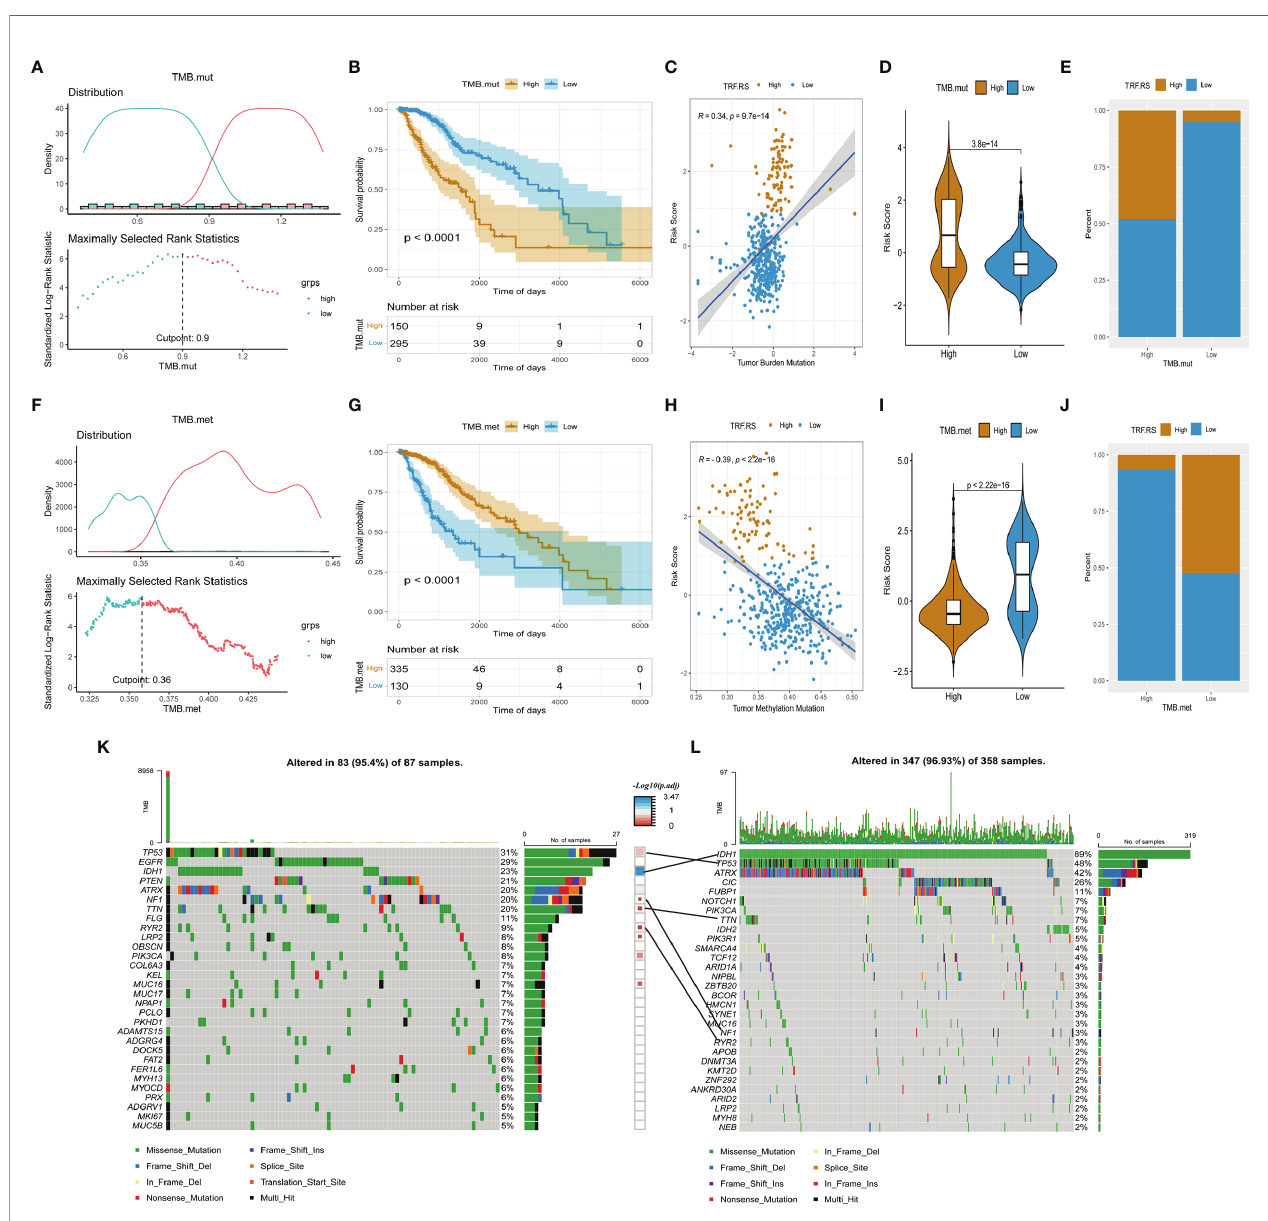
FIGURE 6 | Genomic and methylation characteristics in the high- and low-risk score group from TCGA-LGG cohort. (A, F) Determine the optimal cut point for TMB.mut and TMB.met. (B, G) Comparison of overall survival between the low and high group of TMB.mut and TMB.met. (C, H) Scatter distribution of the risk score with TMB.mut and TMB.met. (D, I) Comparison of the risk score between the low and high group of TMB.mut and TMB.met. (E, J) Comparison of the proportion of risk score type between the low and high group of TMB.mut and TMB.met. (K, L) Oncoplot of the high and low group of risk